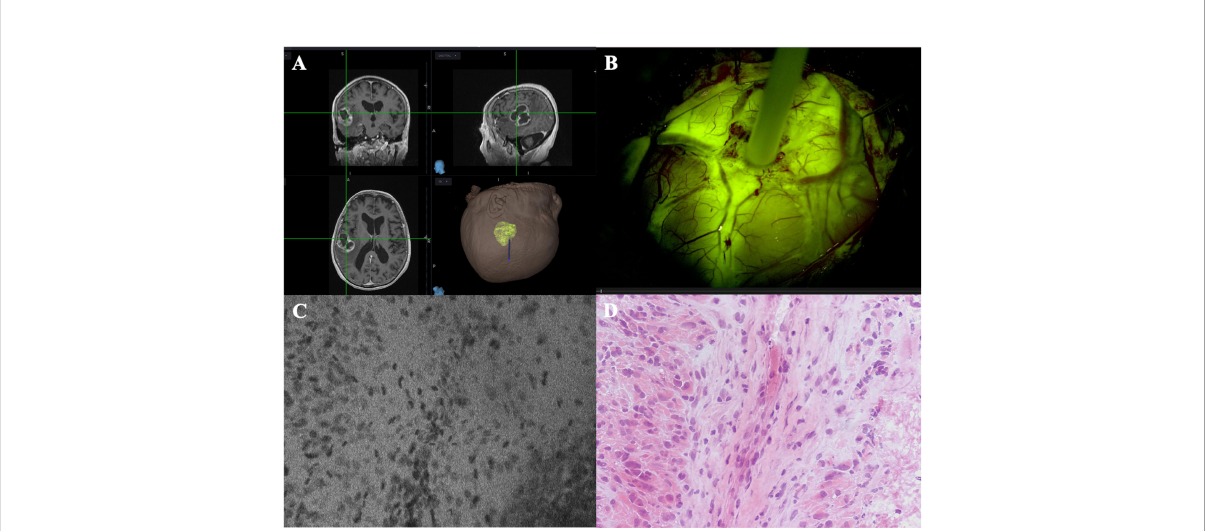
FIGURE 3 Case example of an in vivo GBM case analyzed with CONVIVO (courtesy of Dr. Acerbi and Dr. Pollo, Fondazione IRCCS Istituto Neurologico Carlo Besta, Milan, Italy). (A) MRI preoperative images of a left parieto-temporal GBM, loaded on Stealth S8 navigation system (Medtronic, Minneapolis, USA). (B) CONVIVO stylet placed upon the center of the tumor, on the cerebral surface. As it can be seen, the tumor intensely enhances after intravenous SF administration. (C, D) CONVIVO and histological images of the point where the optical biopsy with CONVIVO was obtained. Disordered groups of dark nuclei cells can be seen, along with a stromal component among them. A low fl uorescence area on CONVIVO, as it occurs in necrotic parts of the tumor, can be seen in the bottom right of panel (C) , with its histological counterpart in the bottom right of panel (D)